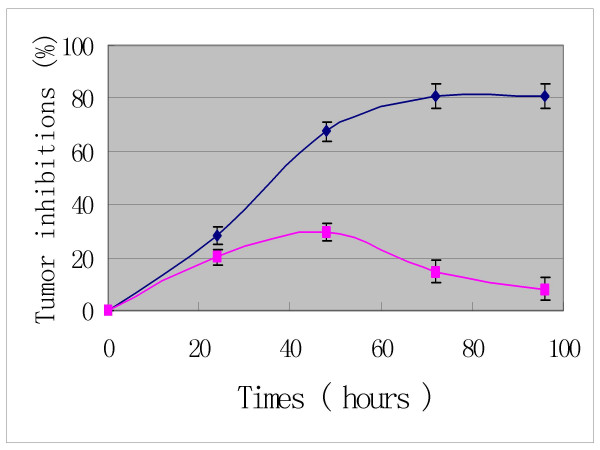
Time- response curve of probimane inhibiting a human mammary cell line (MDA-MB-435). MTT method was used. A: Pro concentration at 50 μM (dark); B: Pro concentration at 5 μM (purple).